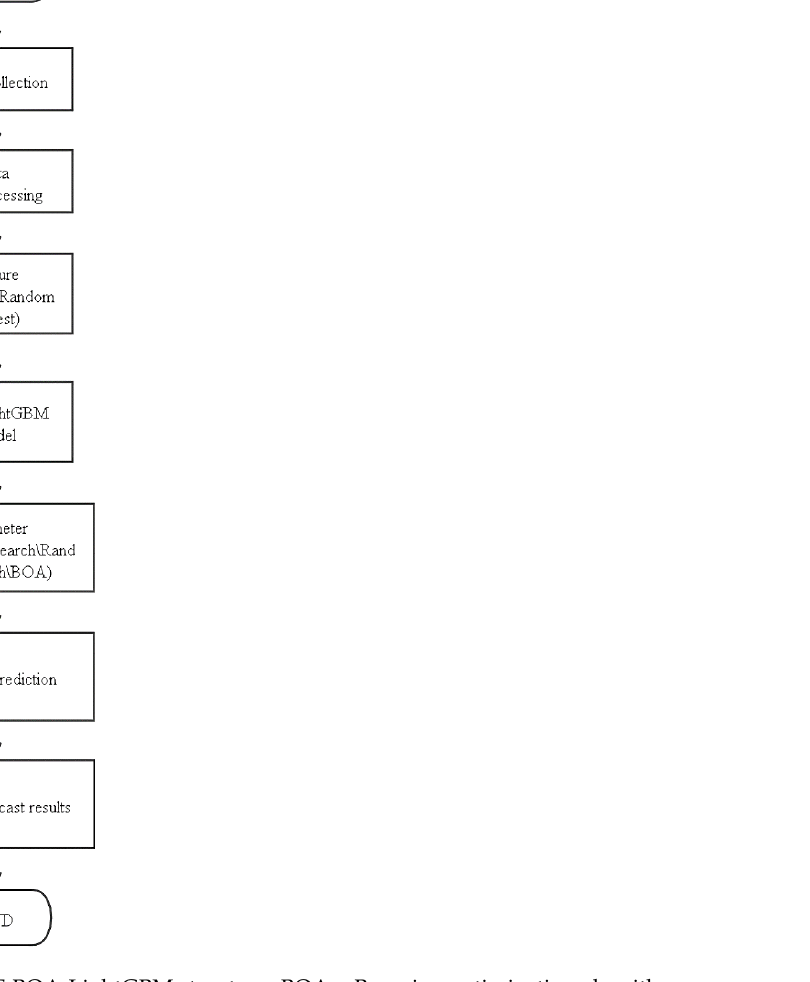
Figure 6. RF-BOA-LightGBM structure. BOA = Bayesian optimization